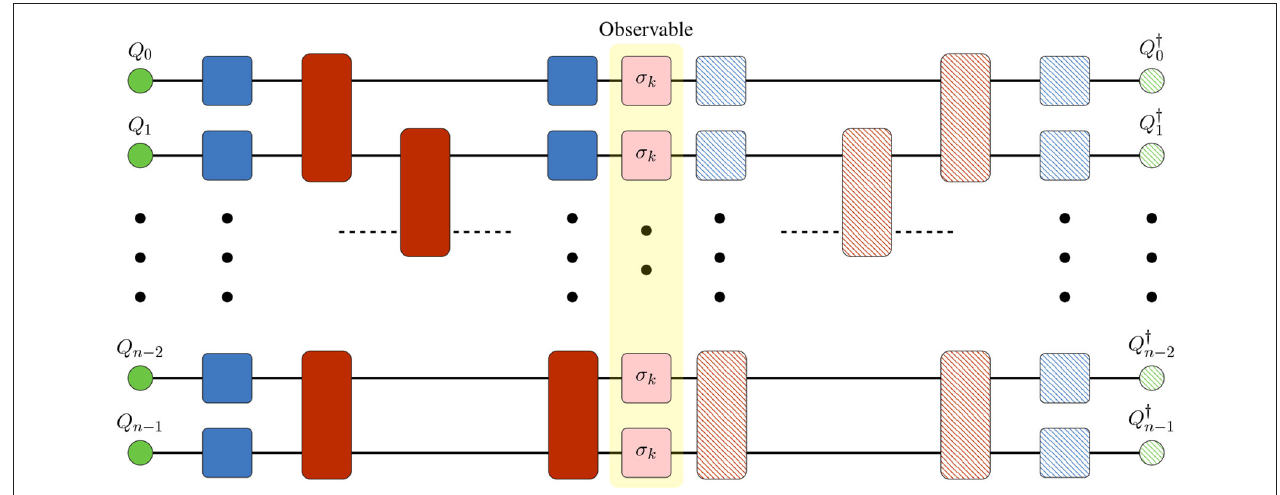
FIGURE 6 | ExaTN tensor network for expectation value evaluation using the circuit conjugation technique. Hashed-filled tensors represent the complex conjugates of the solid-filled counterparts.